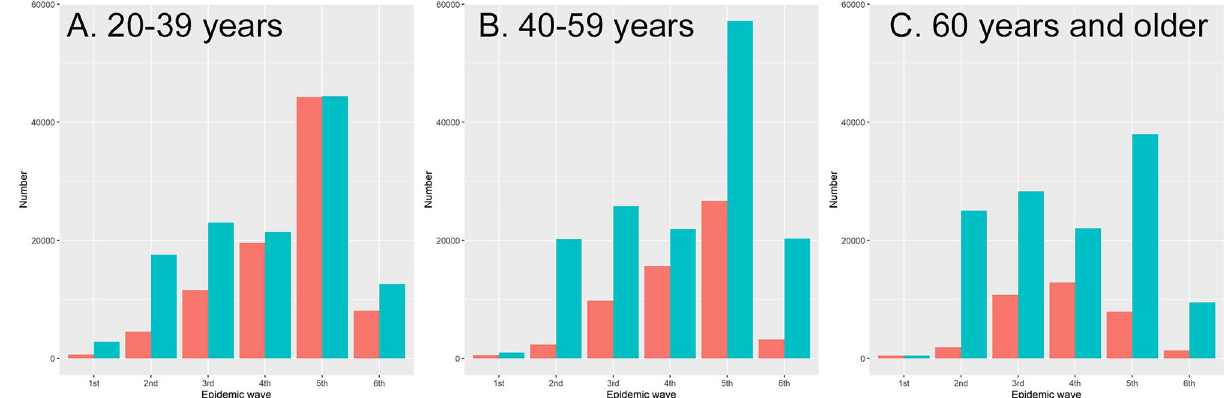
Figure 1. Comparison between observed confirmed cases and estimated number of infections with COVID-19 in Osaka, Japan, 2020–2022. The horizontal axis shows the epidemic wave in Japan from 2020 to 2022, while the vertical axis represents the absolute number of cases. The red bars represent the observed number of confirmed cases, while the blue bars show the estimated number of infections. The left panel ( A ) shows estimates for young adults aged 20–39 years, the middle panel ( B ) for those aged 40–59 years, and the right panel ( C ) shows the elderly aged 60 years and older.